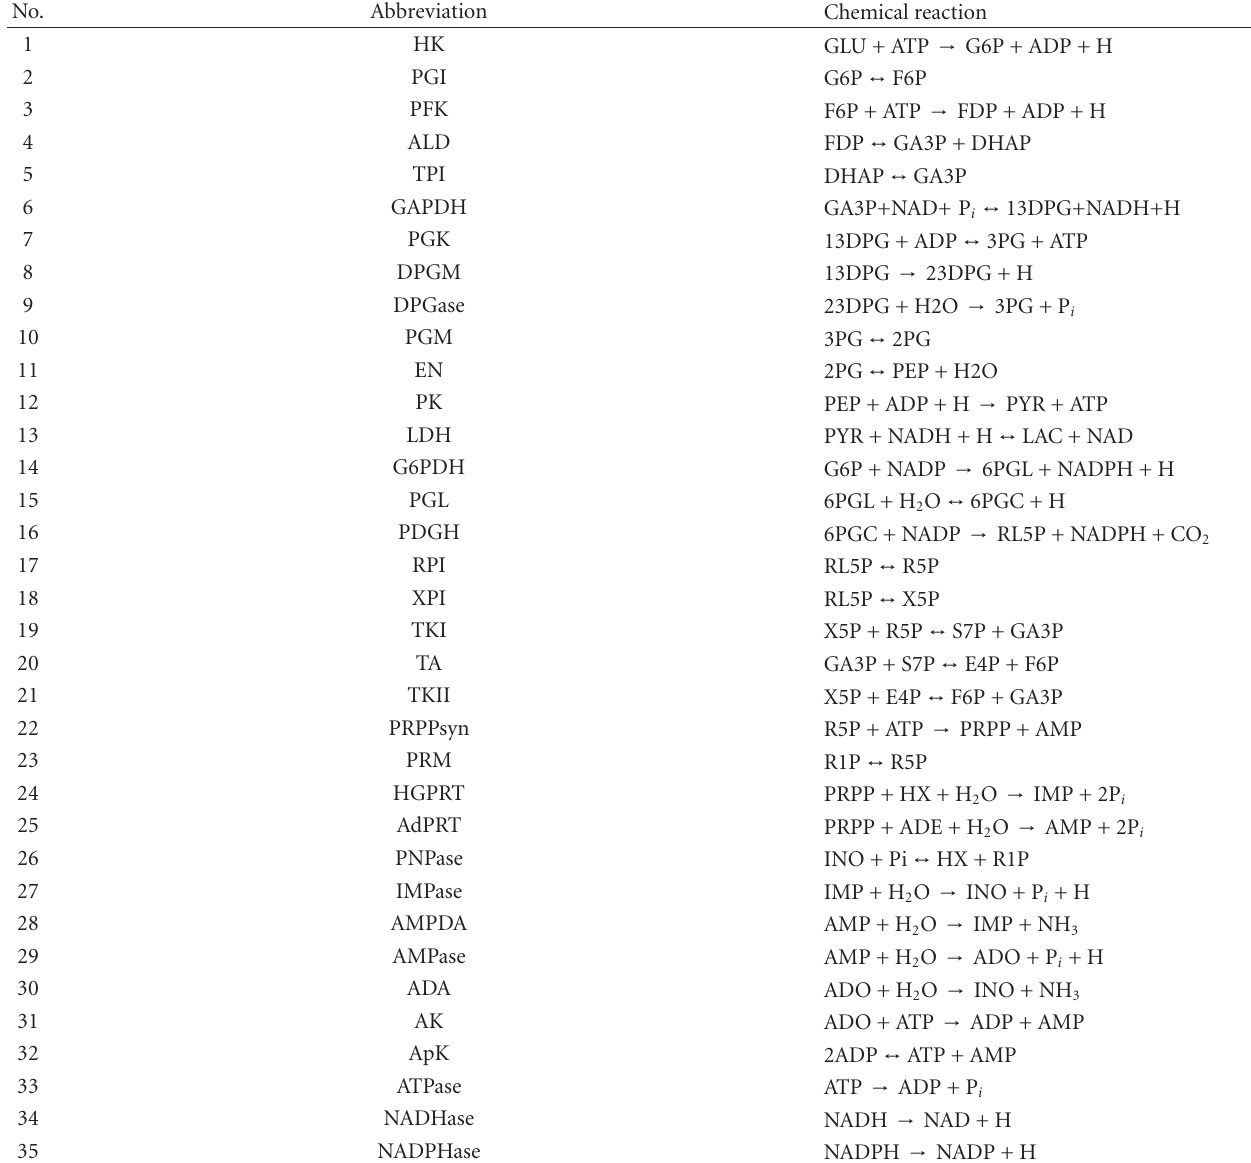
Table 1: List of reactions considered in this work, including the corresponding number in the map of Figure 2, the abbreviation and the process. The 7 uptake fluxes, numbered 36 to 42, are as shown in Figure 2.